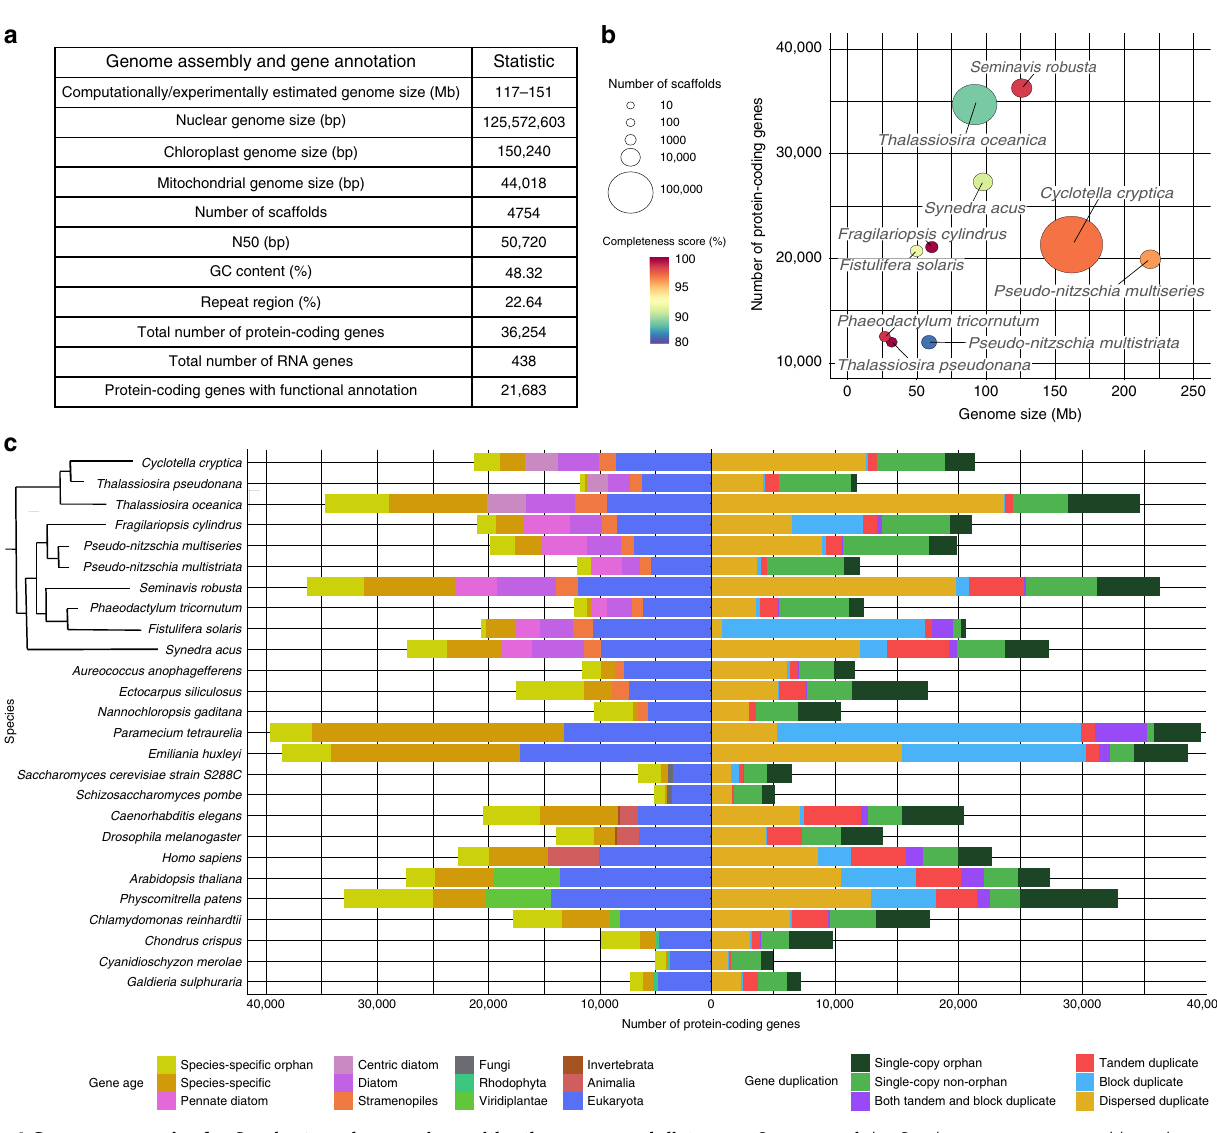
Fig. 1 Genome properties for S. robusta and comparison with other sequenced diatoms. a Summary of the S. robusta genome assembly and gene annotation statistics. b Scatter plot showing genome assembly contiguity and gene family completeness score in sequenced diatom genomes. Every dot represents a diatom genome assembly. The x axis displays the genome size in Mb, whereas the y axis represents the number of protein-coding genes. Genome assemblies are colored according to the gene family completeness score in a rainbow scale from blue to red. The size of the circle indicates the number of scaffolds in the genome assembly. c Comparative genomics analysis among diatoms and other eukaryote species. Left side of the barplot represents the age of the genes inferred through phylostrati fi cation, whereas the right side represents the duplication information. The phylogenetic relationship between diatom species is shown in a